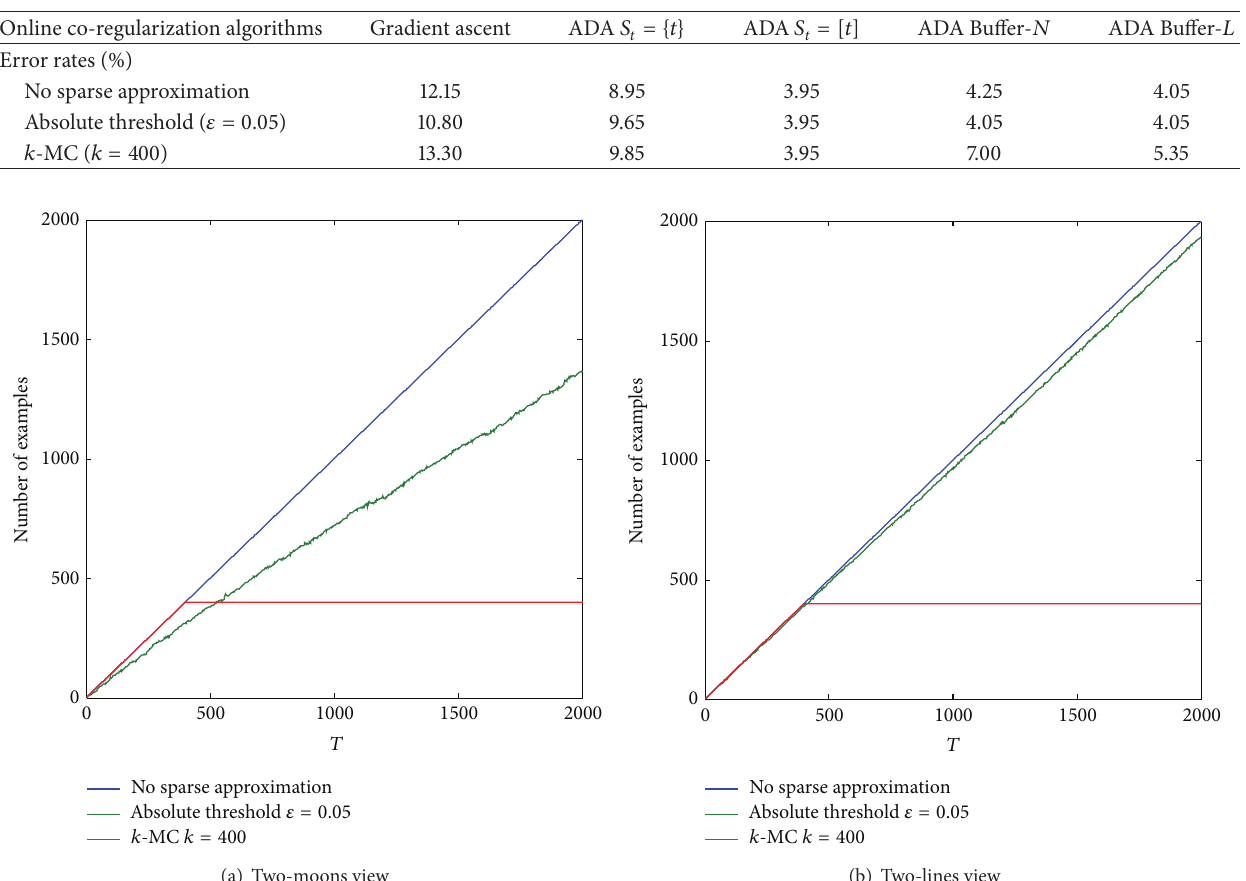
Table 2: Mean test error rates on the two-moons-two-lines synthetic data set. The error rates are reported for three different sparse approximations. For gradient ascent, we choose a decaying step size 𝜌 𝑡 = 0.1/√𝑡 . The result shows that our derived online co-regularization algorithms achieve test accuracy comparable to offline co-regularization (CoLapSVM). The online co-regularization algorithms based on aggressive dual ascending procedures perform better than those based on gradient ascent.